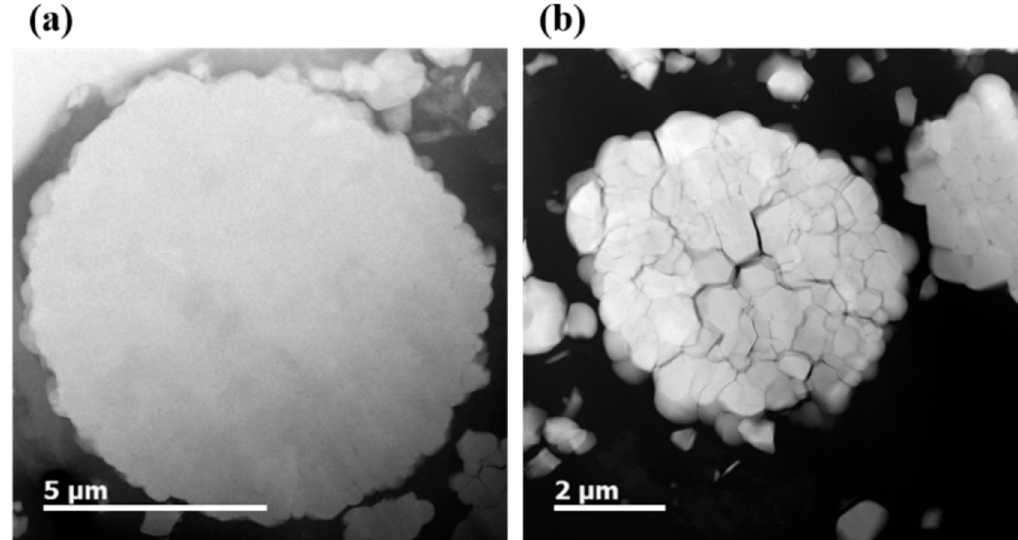
Figure 2. Cross-sectional scanning transmission electron microscopy (STEM) images for NCM811 ( a ) before cycling (bare) and ( b ) after 600 cycles at 45 °C.